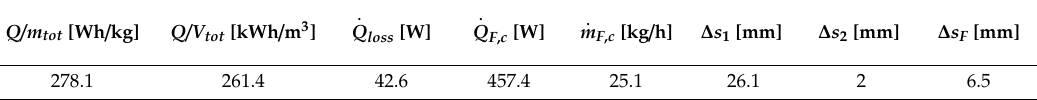
Table 7. Example system of the alternative concept—central results at maximum permitted surface temperature and maximum cooling flow outlet temperatures of each 60 ◦